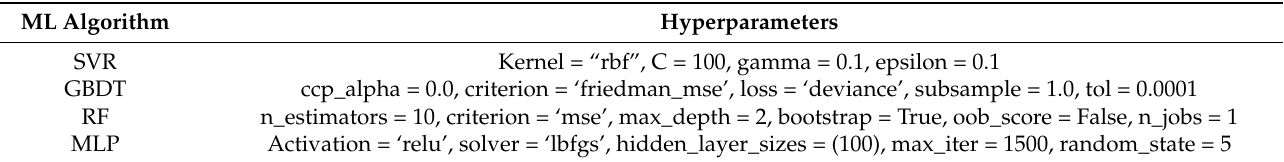
Table 2. Optimal hyperparameters for the four models.